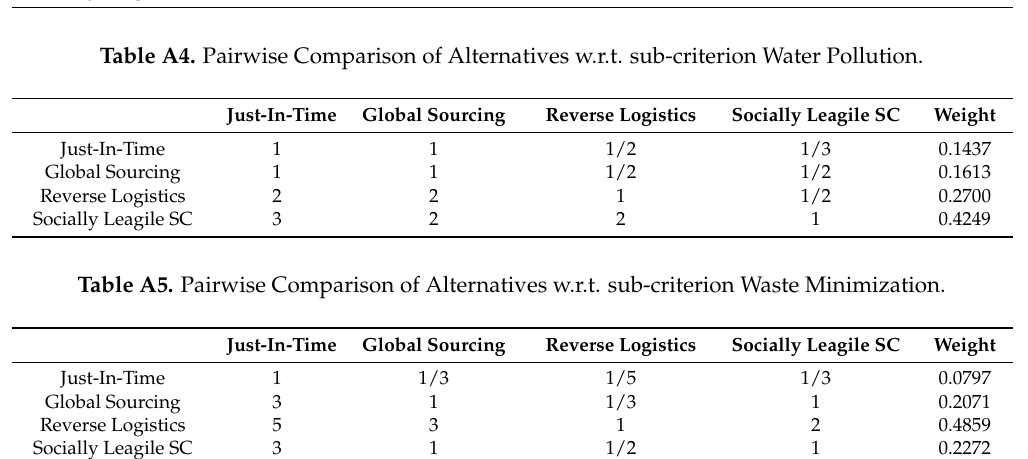
Table A3. Pairwise Comparison of Alternatives w.r.t. sub-criterion Resource Consumption. Just-In-Time Just-In-Time